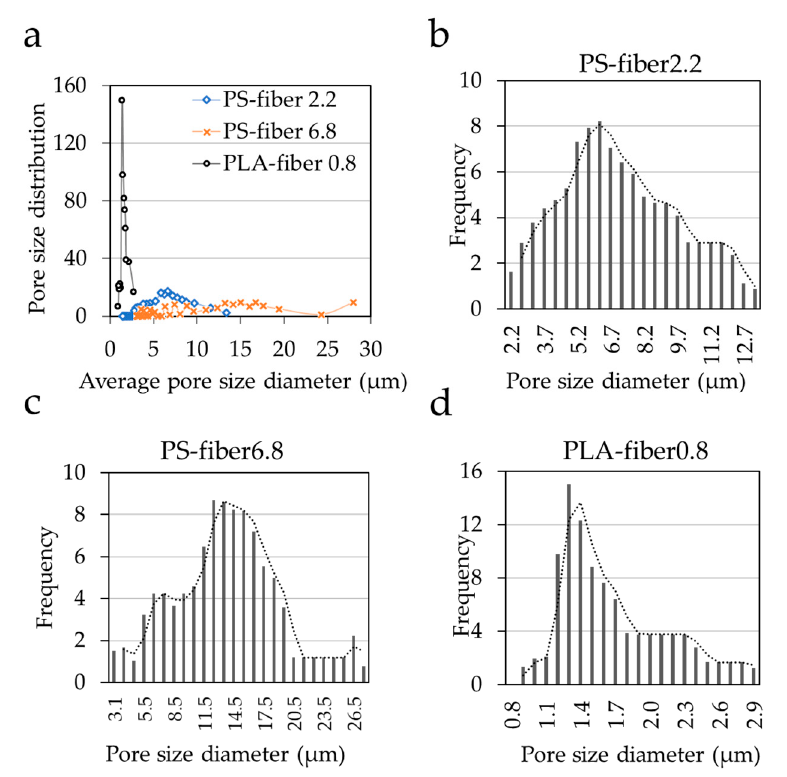
Figure 5. Pore size distribution ( a ) pore size distribution vs. average pore size diameter in µ m of all electrospun webs; ( b – d ) Electrospun webs pore size distribution vs. diameter in µ m of PS-fiber2.2, PS-fiber6.8, and PLA-fiber0.8.